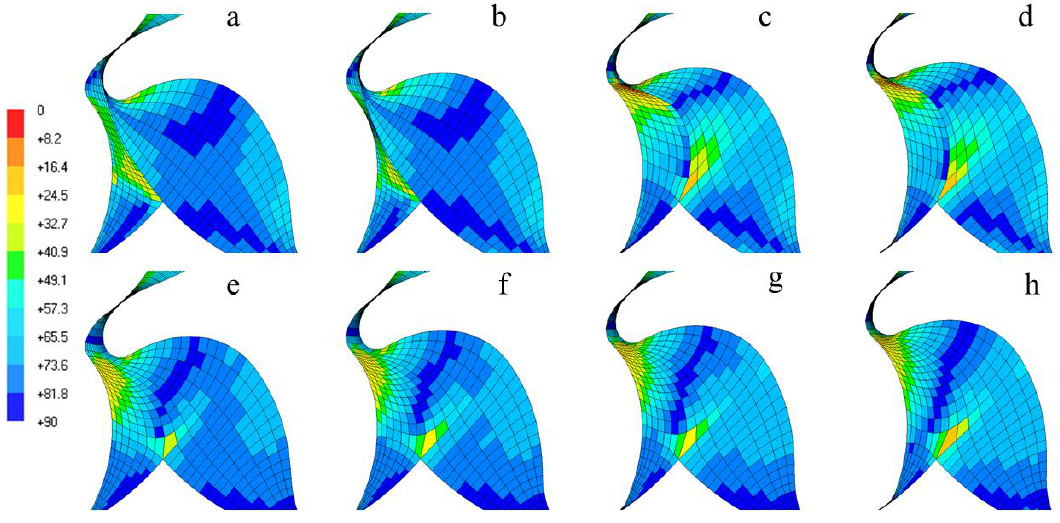
Figure 6. Comparison of cell orthogonal quality between algebraic ( a – d ) and elliptic ( e – h ) meshing.